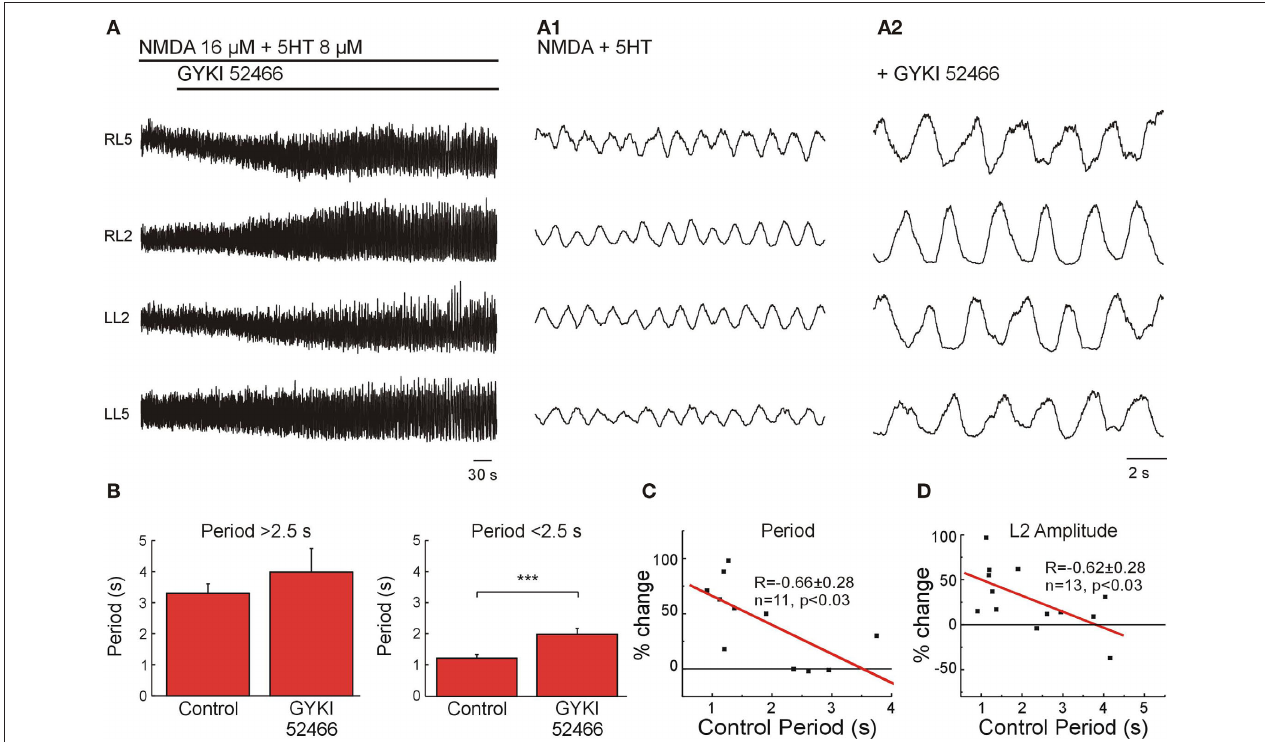
period (as % of change with respect to control) as function of the control period showing that the effect of GYKI 52466 was linearly proportional to the control locomotor period ( R = − 0.66, n = 11, p < 0.03). (D) Plot of the amplitude modulation of the L2 VR bursts (% change with respect to control) as a function of the control period showing and inverse linear correlation ( R = − 0.62, n = 13, p < 0.03) indicating that GYKI 52466 increased the amplitude at high locomotor frequencies but had no effect at lower locomotor